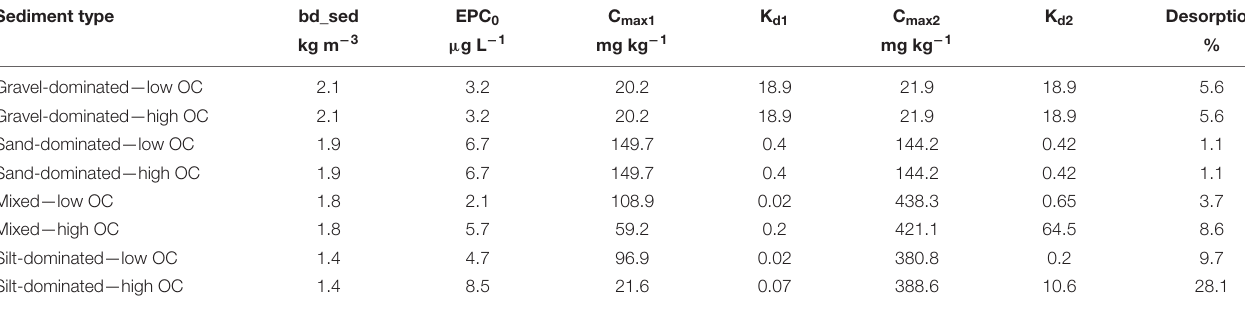
TABLE 5 | Phosphorus equilibrium concentrations (EPC 0 ) for the studied sediment